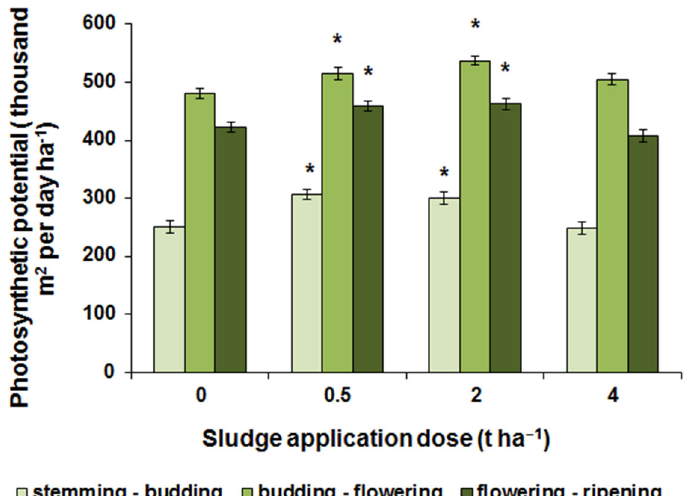
Figure 11. Photosynthetic capacity. *—significant differences with the control.